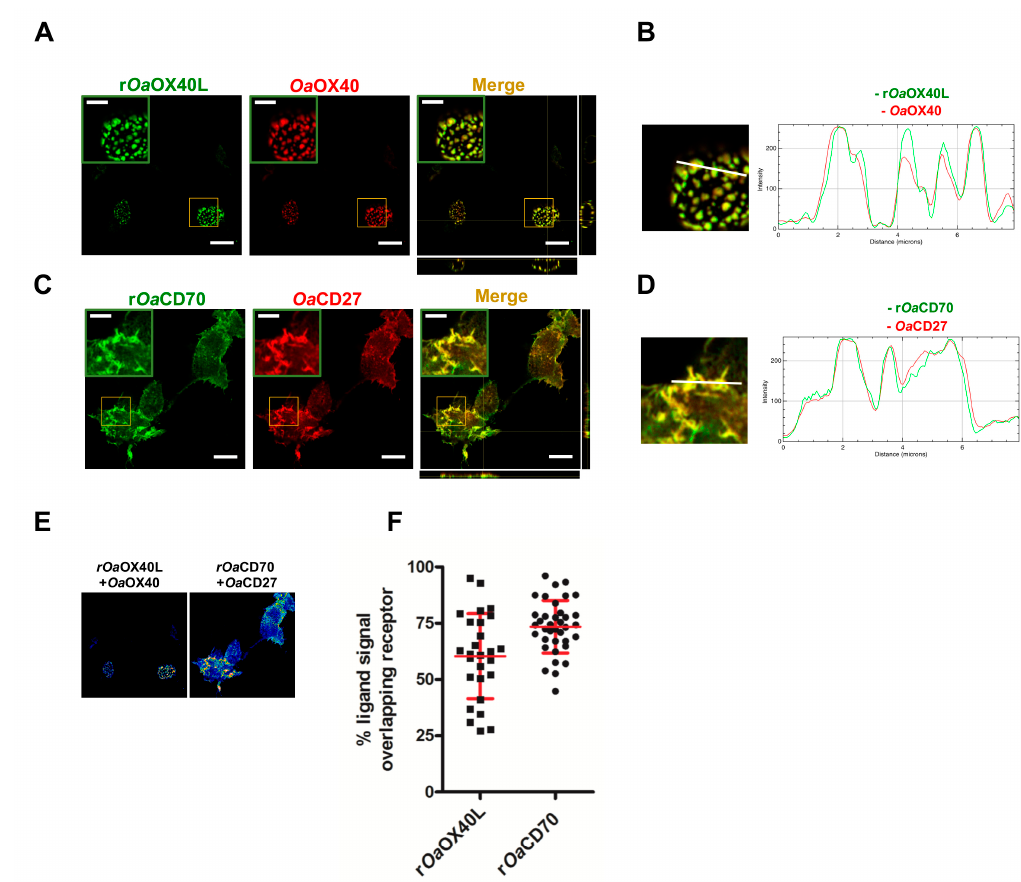
Figure 4. The secreted r Oa OX40L and r Oa CD70 expressed from recombinant adenovirus-infected cells colocalise with their cognate ovine receptors. Cells expressing ( A ) Oa OX40 or (C) Oa CD27, were incubated with conditioned media from cells infected with ( A , B ) Ad5- Oa OX40L (r Oa OX40L) or ( C , D ) Ad5- Oa CD70 (r Oa CD70) for 15 min before fixation and immunofluorescence. r Oa OX40L and r Oa CD70 were detected with an anti-Fc antibody (green); Oa OX40 and Oa CD27 expression was detected using anti-V5 tag antibodies (red). ( B , D ) Insets show detail of colocalisation for each case. Merge and orthogonal projections were obtained with ImageJ software. Scale bar = 10 µ m, indent scale bar = 4 µ m. In panel ( B ) and ( D ), an enlarged image of corresponding insets in Merge and fluorescence intensity profiles for the indicated white lines on the images are shown. ( E ) Representative images of colocalisation analysis in a Z-plane (presented as 16LUT signal) are shown. The ImageJ calculator tool was used for pixel colocalisation for the fluorescence channels of ligands (r Oa OX40L or r Oa CD70) and their respective receptors (r Oa OX40 or r Oa CD27). ( F ) The percentage of ( E ) adenovirus-produced ligands signal colocalising with their receptors was analysed in 25–40 cells for each condition. Mean ± SD are indicated for each condition.